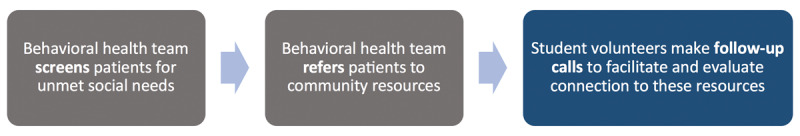
Community Health Center Help Desk Model.